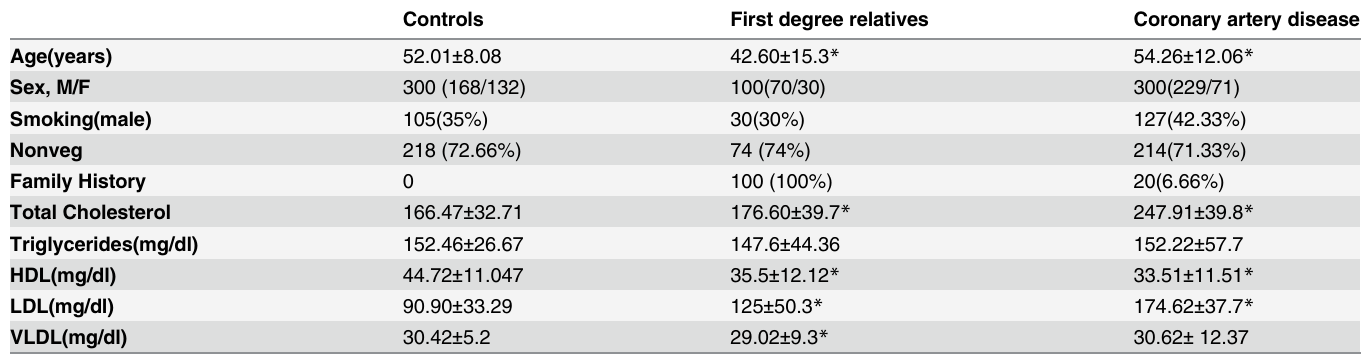
Table 1. Clinical and Demographic data of